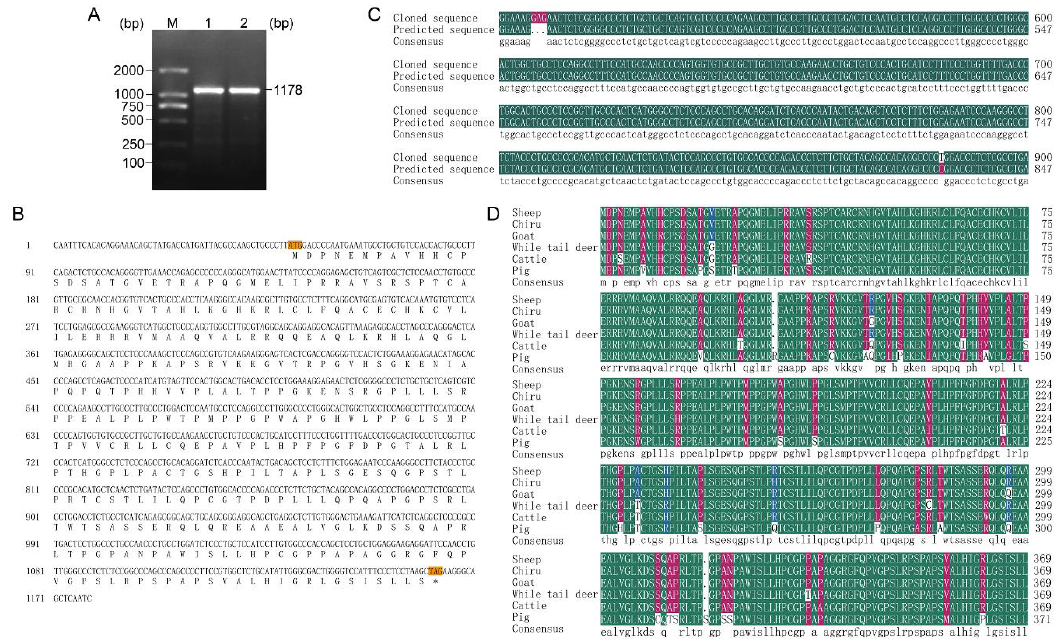
Figure 1. Full-length coding sequence (CDS) cloning and sequence analysis of Tibetan sheep DMRTC2 gene. ( A ) Results for PCR amplification of DMRTC2 cDNA. M, DL2000 marker; 1-2, DMRTC2 RT-PCR